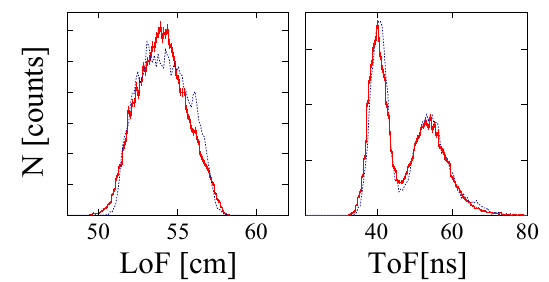
Figure 2. Distributions of the LoF (left) and the ToF (right) of fragments issued from spontaneous fission of a 252 Cf source. The Figure 1. Drawing of the two-arm-FALSTAFF-spectrometer. Each arm is made of two ToF detectors followed by an energy detector red line is the data measured with the FALSTAFF setup while the to collect the remaining kinetic energy of the fragments. At the moment the first arm has been built. blue line is the result of a GEANT4 simulation of the setup using GEF.